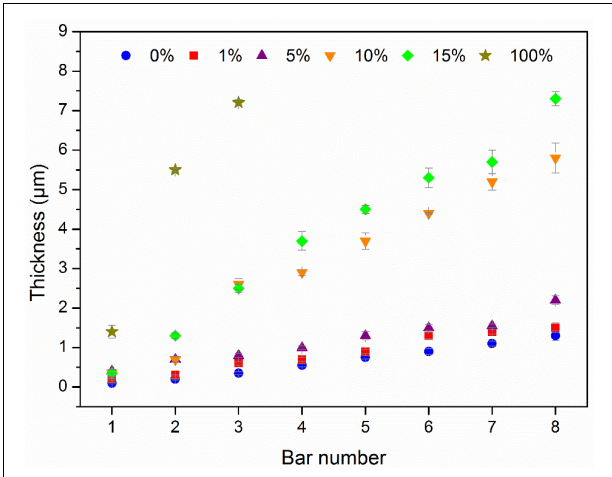
FIGURE 2 | Evolution of layer thicknesses according to the bar number and the wt% of V 2 O 5 . Four measurements per sample were carried out showing a good film homogeneity.